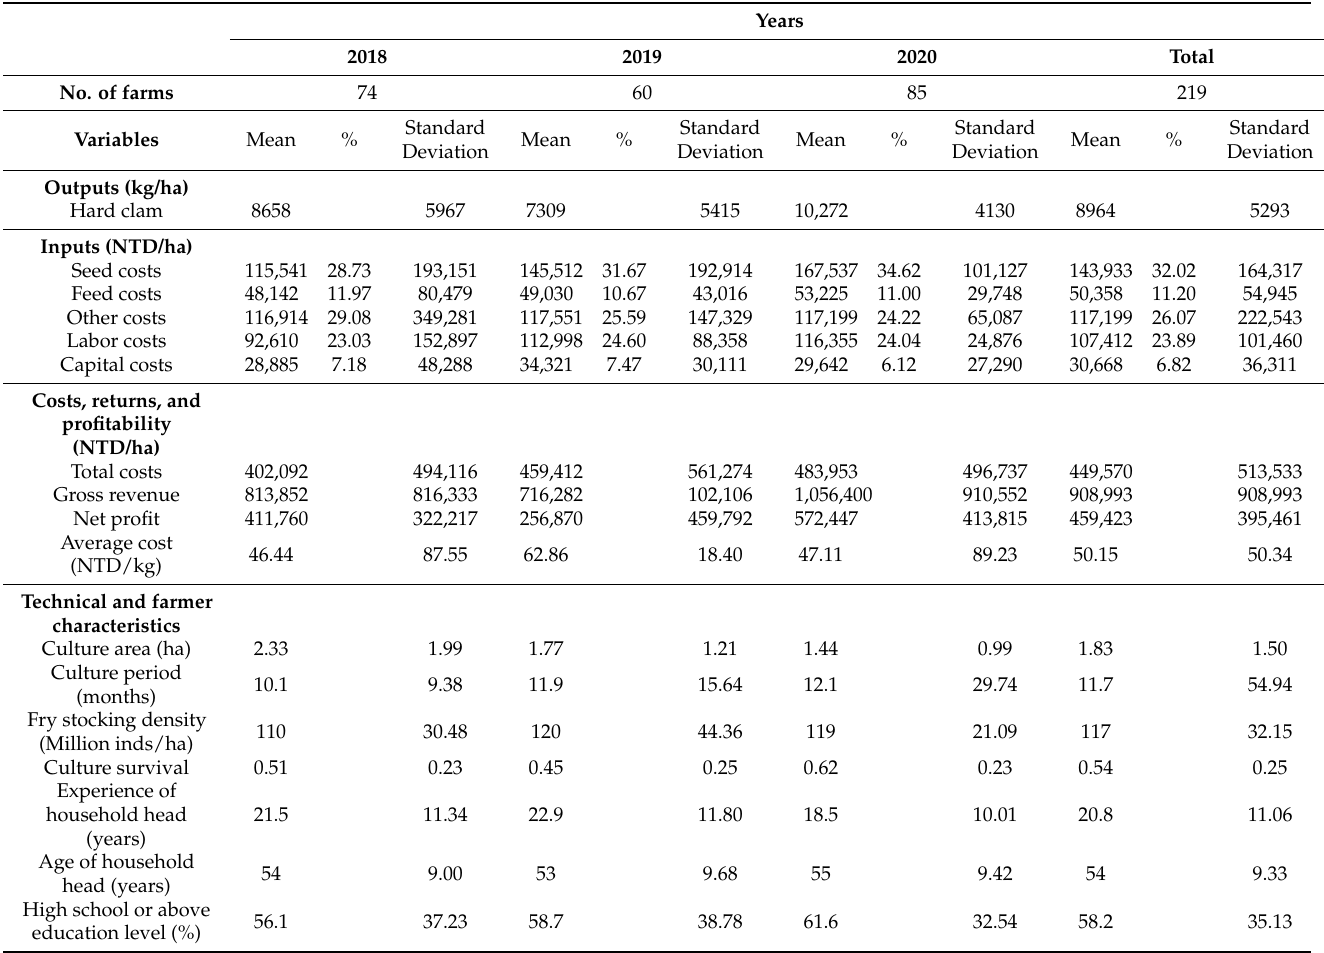
Table 1. Summary of hard clam culture farming profits and cost in Yunlin County, Taiwan